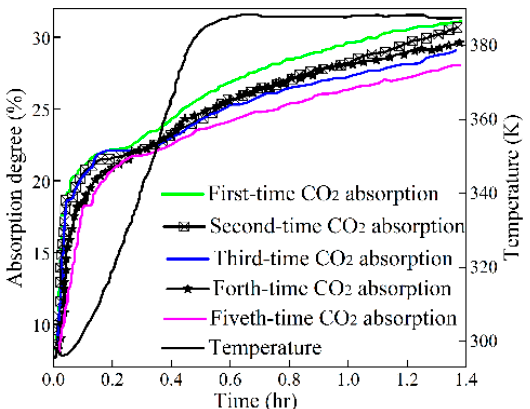
Figure 5. Repetitive cycles absorption on absorption degree of LiTiO 2 . Table 4. Absorption degree of LiTiO 2 for the repetitive cycles .